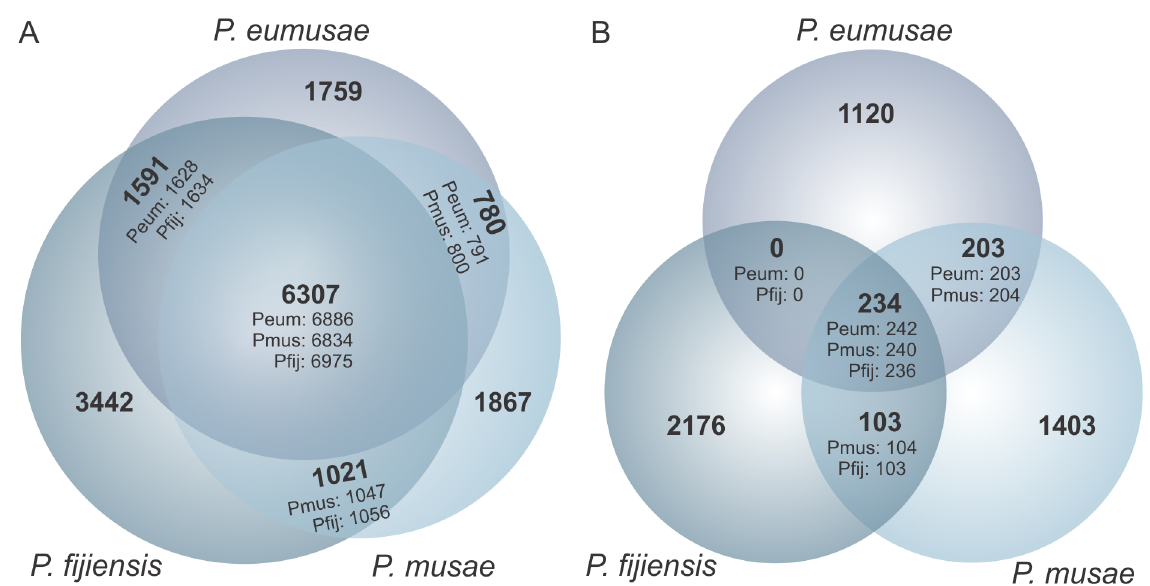
Fig 4. Shared and species-specific gene families and genes in Pseudocercospora musae , Pseudocercospora eumusae , and Pseudocercospora fijiensis . (A) Venn diagram showing the total number of species-specific genes and shared gene families among the three species, as determined by reciprocal BlastP best hit (e-value: 1e-5) analysis implemented in OrthoMCL. A larger number of species-specific genes are found in P . fijiensis , whereas more gene families are shared between P . eumusae and P . fijiensis as compared to P . eumusae and P . musae , or P . musae and P . fijiensis . (B) The Venn diagram is expanded to include a broader comparison of the three species gene content against the NCBI nr database and the JGI fungal genome database (BlastP e-value: 1e-5, alignment coverage > 50%). In both Venn diagrams, the number of genes from each species included within the pool of shared gene families is indicated at every